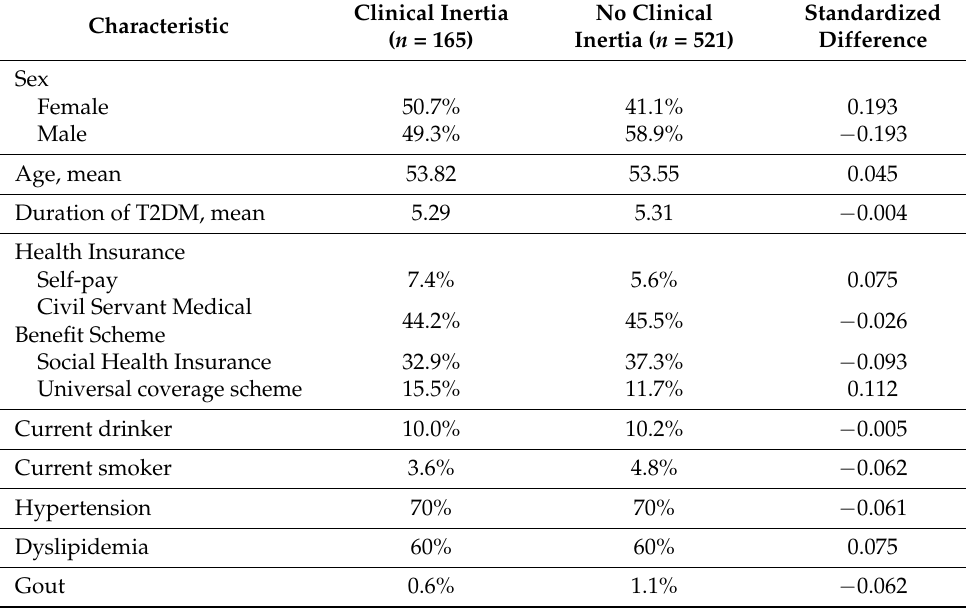
Table A2. Balance of patient characteristics after